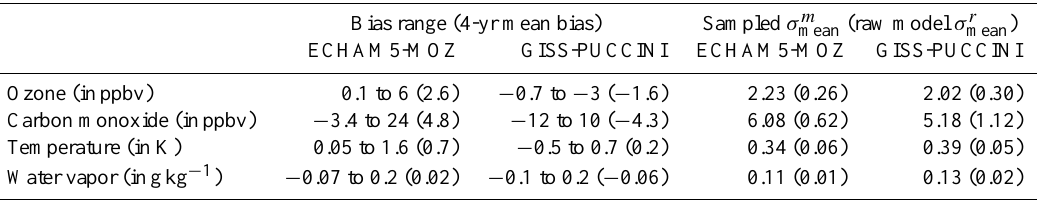
Table 1. The range of bias S G between the mean of the sampled y m and the raw model time-series y r at the gridpoint G corresponding to 20 ◦ E longitude and 18 ◦ S latitude for the individual years shown in Fig. 3 are shown on the second and the third columns respectively for ECHAM5-MOZ and GISS-PUCCINI models, respectively. We also show the 4-yr mean bias between the two distributions in the parenthesis on the second and the third columns. The fourth and the fifth columns contain the standard error of the 4-yr mean of sampled σ m mean time- series (and raw model time-series σ r mean in parenthesis) as specified in Eq. (9) (and Eq.